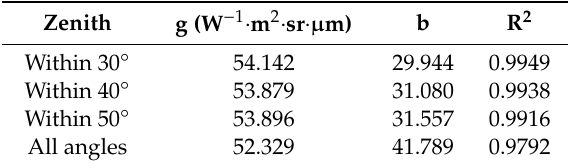
Table 4. Fitting results of different MODIS-view zenith angles (2011).